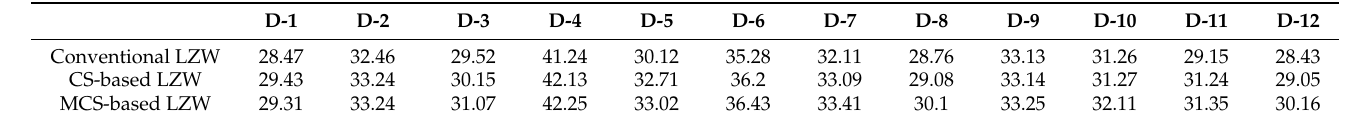
Table 5. SS comparisons of three LZW algorithms